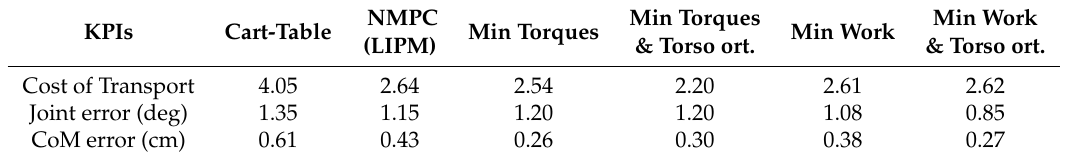
Table 6. [Hardware experiment result.] Key Performance Indicators (KPIs) for the ending step.